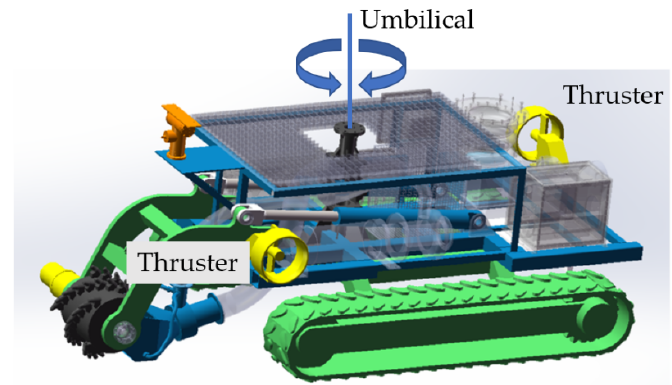
Figure 6. Schematic diagram of orientation function. Table 8. Propeller parameters.